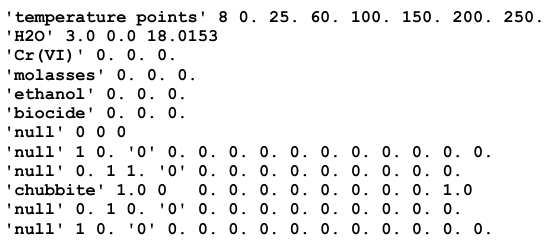
Figure A3. Minimal CHROTRAN chemistry database. The text shown here should not be removed. However, additional species may be added, if desired. See PFLOTRAN user manual for details on the database